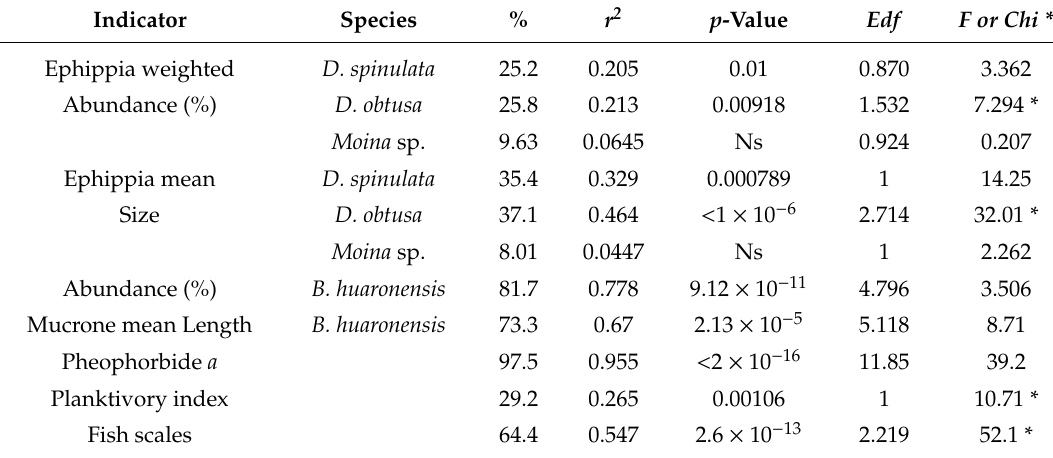
Table 1. Results from generalized additive models (GAMs) fitted to the temporal series of the di ff erent proxies from the sedimentary record of Lake Blanca Chica. The estimated degrees of freedom ( edf ), F -statistic (Gaussian distributions) or chi -statistic (scaled or gamma distributions, values denoted by *), and p -values of the smooth term and the percent (%) of the deviance explained by the fitted model are shown. The significance level was set at p < 0.05; ns: non-significant results. All the fitted models were estimated using continuous time first-order autoregressive process (CAR(1)) and restricted maximum likelihood (REML)smoothness